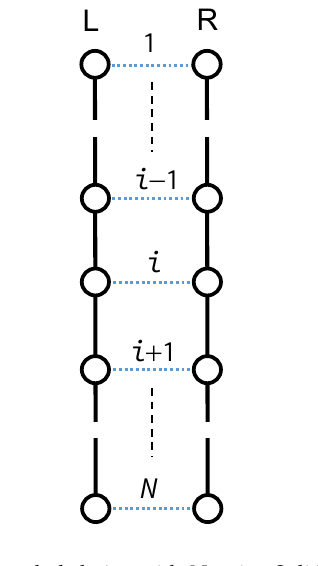
Figure 3. Schematic array of two extended chains with N units. Solid lines denote the C − C interaction, and the dotted lines denote the H · · · H interaction. Stretching is along the vertical